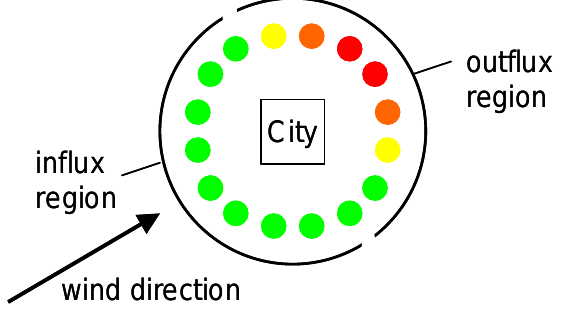
Fig. 2. Example of tropospheric vertical column densities (orange and red colours indicate enhanced values) derived from mobile MAX-DOAS observations around an extended emission source. According to the wind direction a part of the observations characterises air masses entering and a part of them leaving the encircled area.